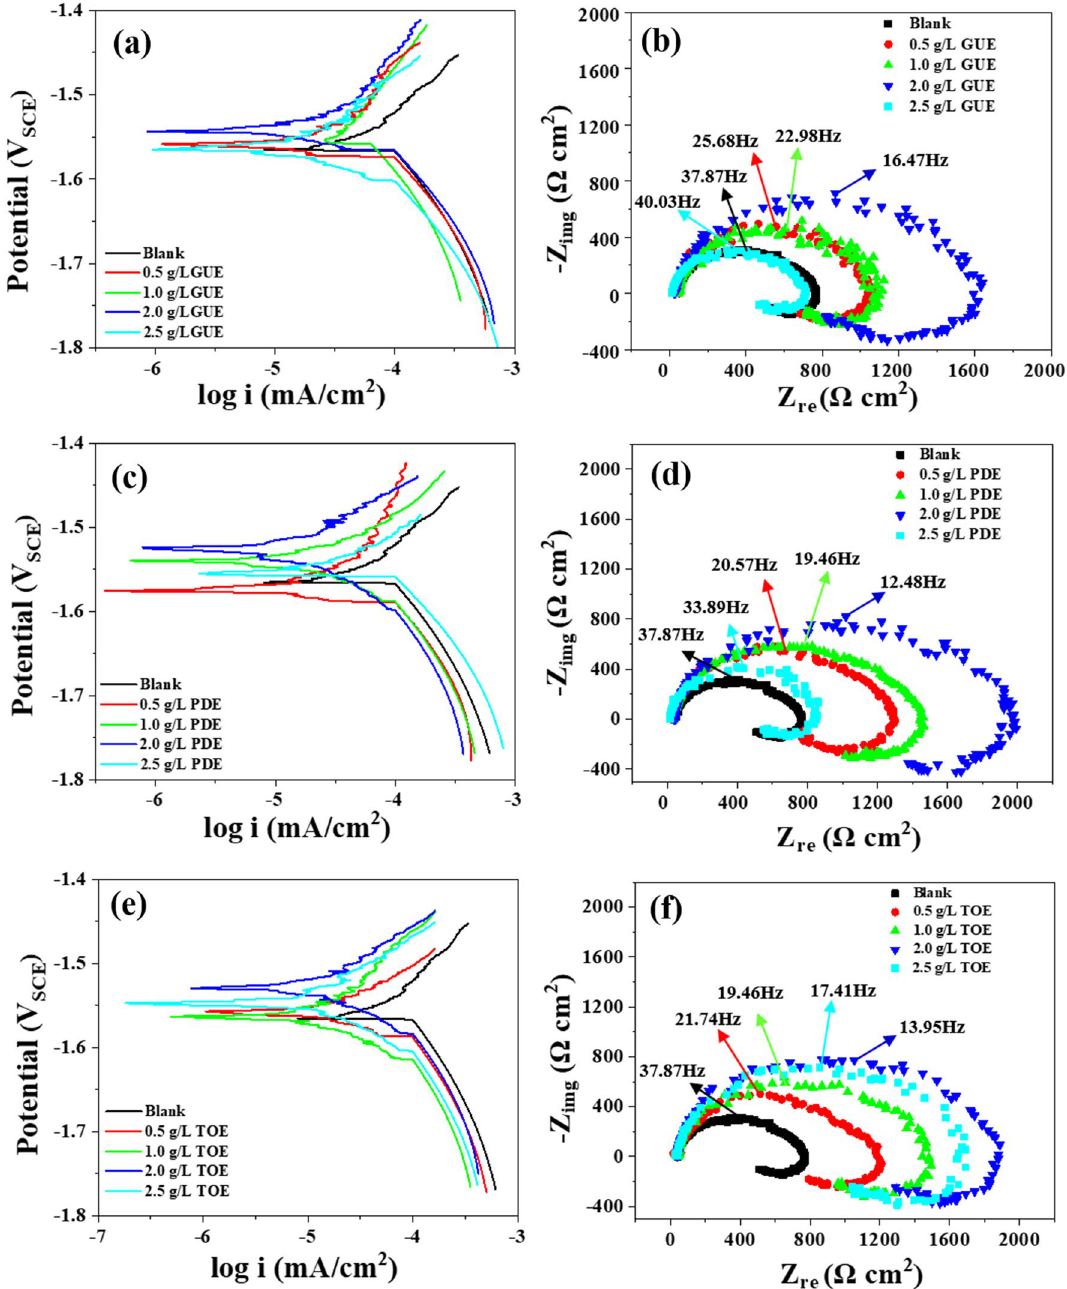
Figure 2. Electrochemical characteristics of AZ91 Mg alloy in 3.5 wt% NaCl solution without and with different concentrations of ( a , b ) GUE, ( c , d ) PDE, ( e , f ) TOE at normal Figure 2b,d,f show the variations of electrochemical impedance spectra with the concentration of GUE, PDE and TOE, respectively. The increased level of GUE, PDE and TOE addition could give rise to an increased size of Nyquist semicircle and therefore a more pronounced corrosion protection. For GUE, as the concentration reached 2.0 g/L, the polarization resistance was increased from 263.91 ± 3.12 to 945.71 ± 4.81 Ω cm 2 and the inhibiting efficiency η EIS was raised to 71.4%. For PDE, the addition level of 2.0 g/L can lead to the increment of polarization resistance to 1476.65 ± 6.33 Ω cm 2 and the η EIS to 81.7%. For TOE, the increased polarization resistance was accompanied by the increased inhibiting efficiency with the increase of addition level. The highest values of polarization resistance and η EIS were 1304.57 ± 9.06 Ω cm 2 and 79.2%, respectively, at the concentration of 2.0 g/L. By comparison, it is evident that the PDP results are in good agreement with those of EIS. The dependence of hydrogen evolution on time during AZ91 alloy corrosion in 3.5 wt% NaCl solution without and with 2.0 g/L GUE, PDE and TOE is illustrated in Fig. 3a. From the H 2 volume-time curves, it can be seen that H